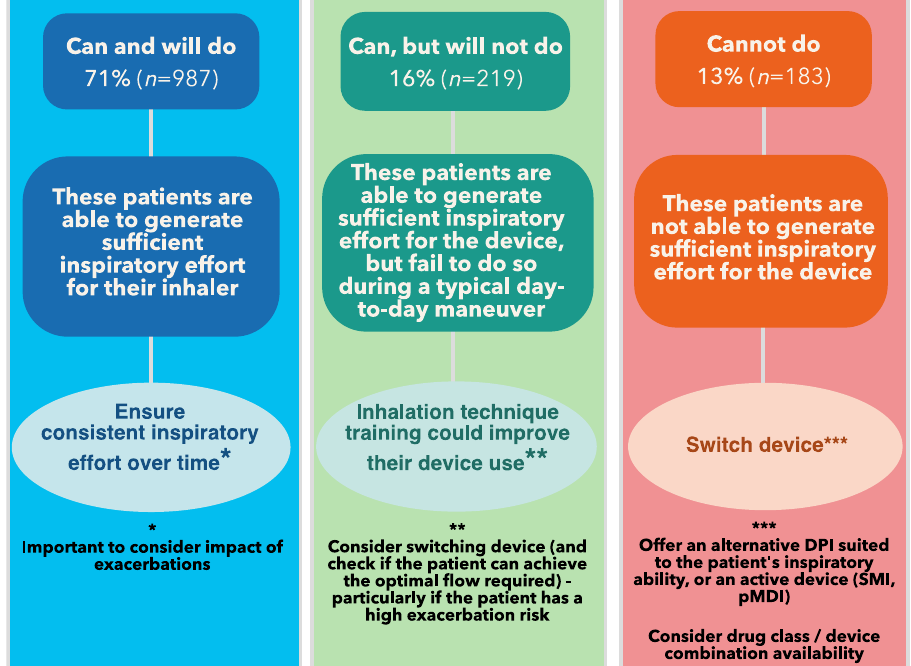
Fig. 2 Decision tree for matching the DPI to the patient with COPD based on Peak Inspiratory Flow. ‘ Can and will do ’ : patients with a typical PIF ≥ than the optimal PIF for their device; ‘ Can, but will not do ’ : patients with a typical PIF below the optimal PIF for their device, but able to generate maximum PIF ≥ the optimal PIF; ‘ Cannot do ’ : patients with both their typical and maximum